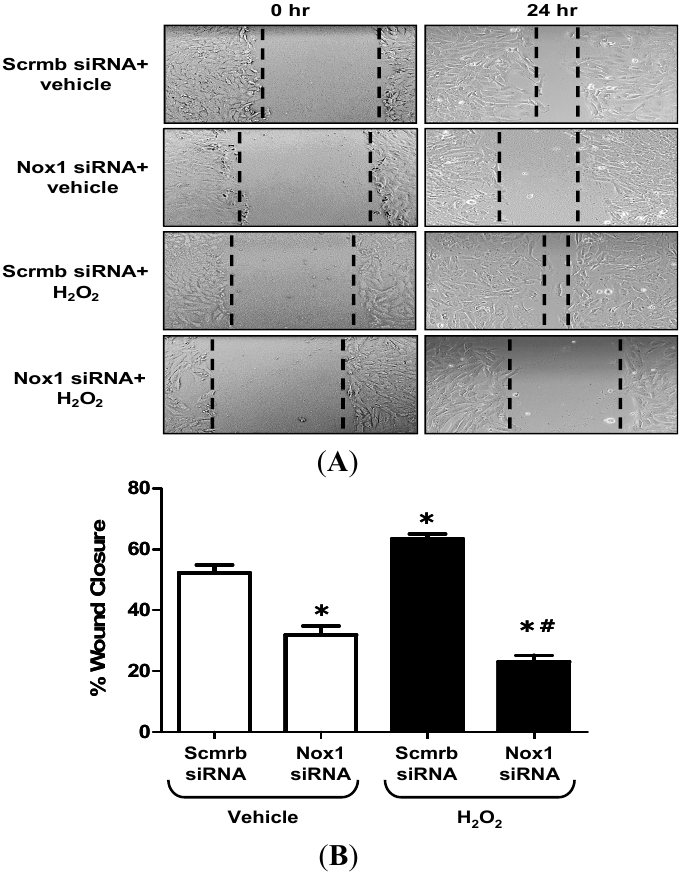
Figure 4. H O stimulates VSMC migration via Nox1. VSMC were transfected with 2 2 Scrmb or Nox1 siRNA and treated with vehicle or H determined by wounding of VSMC monolayers. Wound area was monitored at 0 and 24